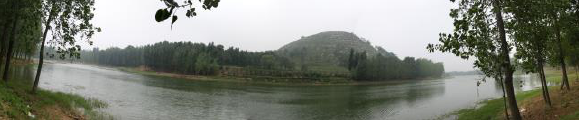
Figure 21. The Xuehe River on the south The generation of Lan was “Shushu gave throne to Xiafu and moved to Lan”. There were several versions of this